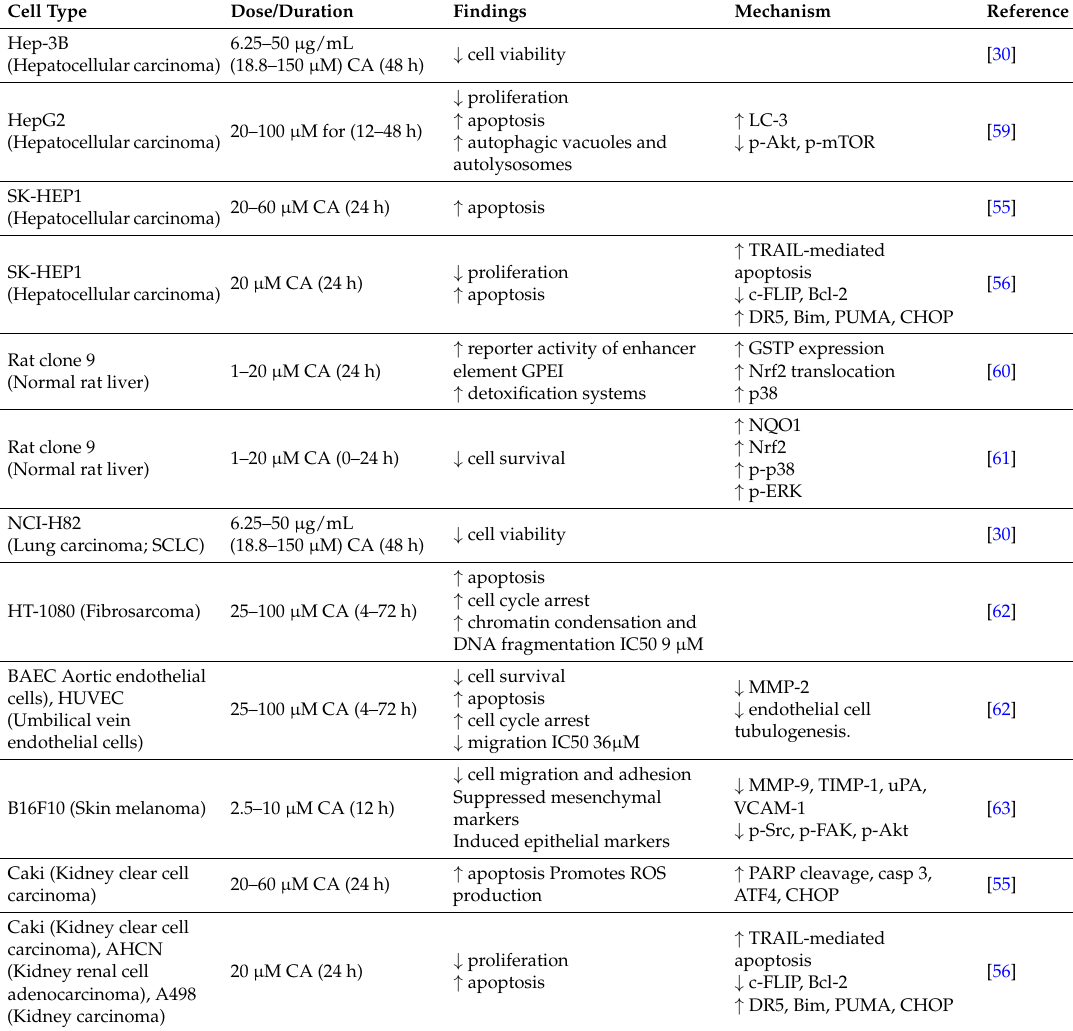
Table 9. Anticancer effects of Carnosic Acid (CA). In vitro studies: liver, lung, skin and kidney